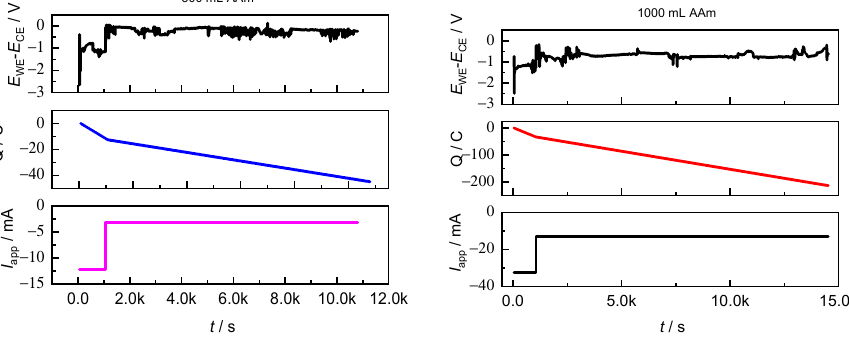
Figure 3. Profiles of E WE - E CE , Q, and I app vs. time recorded during the galvanostatic se ATRP of 10 wt% AAm in H 2 O + 0.05 M NaBr + 0.05 M SP at T = 10 °C. V = 500 and 1000 mL, respectively.